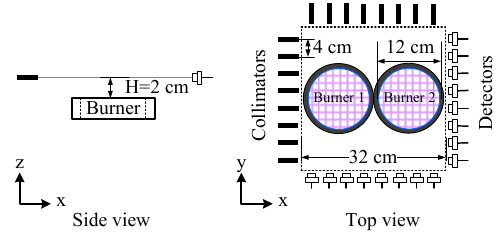
Figure 13. The geometric description of two burners to generate a double peaks flame shape.